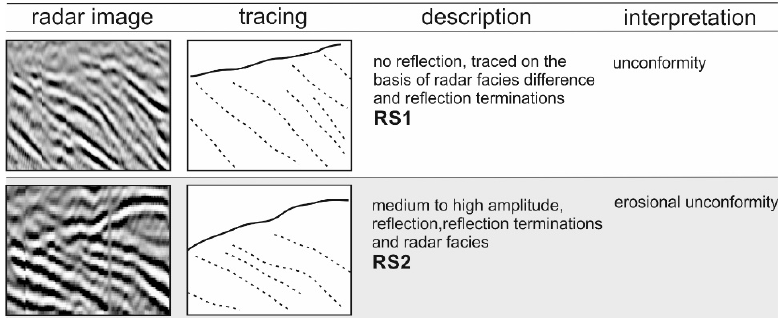
Figure 4. Radar surfaces. GPR image, reflections tracing and interpretation.